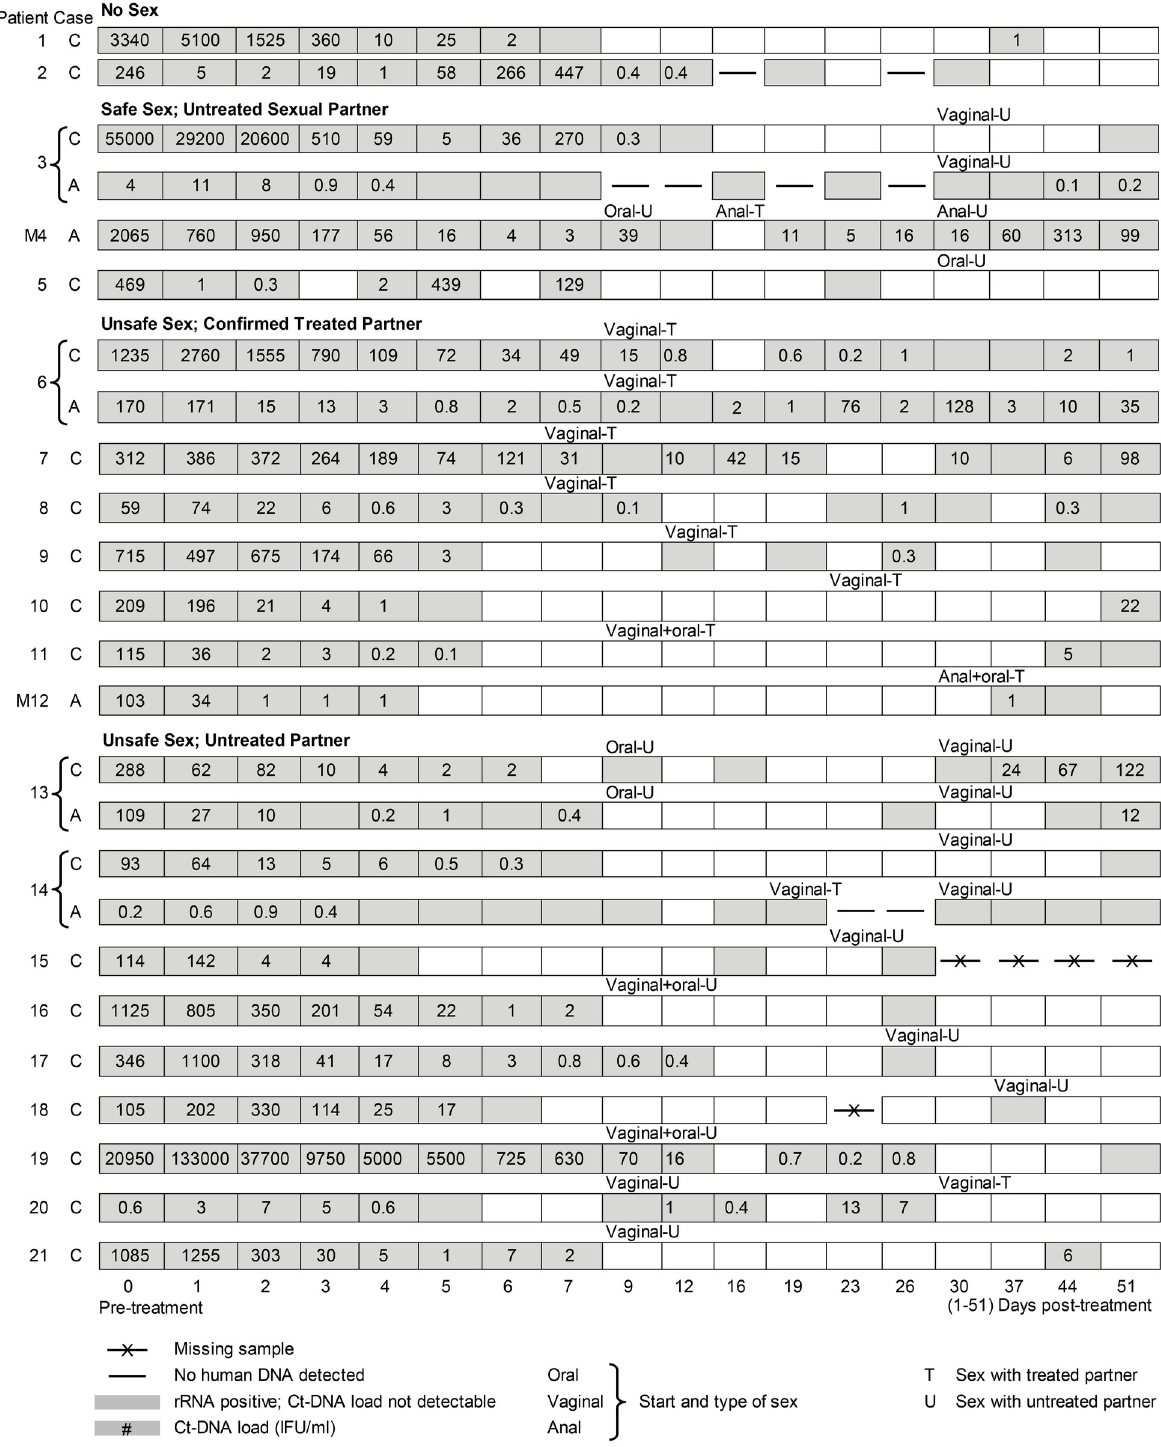
PLOS ONE | https://doi.org/10.1371/journal.pone.0265229 May 10,